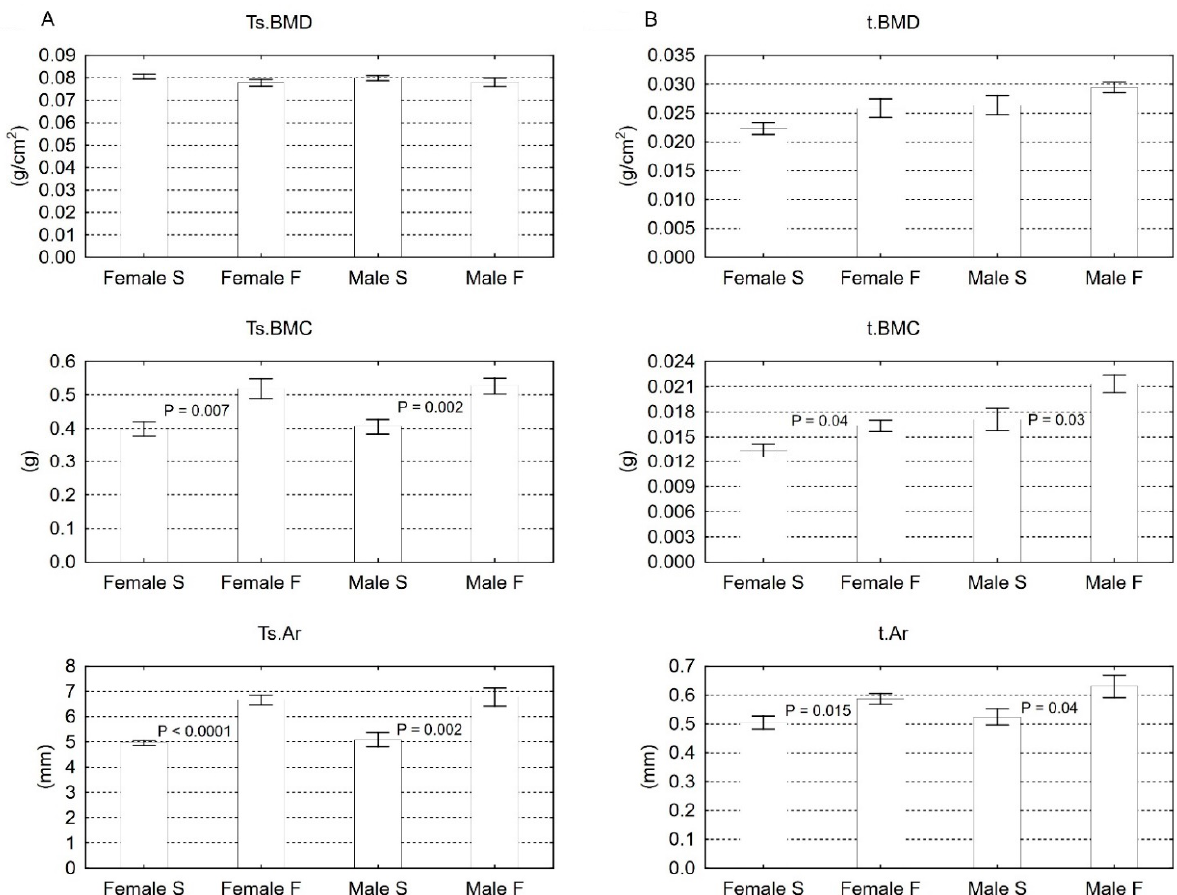
Figure 1. DXA analysis of total skeleton ( A ) and isolated tibia ( B ) of female and male rats on the weaning day. Results are the means ± S.E.M. ( n = 8). Statistically significant differences between S and F groups were established by the t-Student ( p < 0.05). Abbreviations: Ts.BMD–total skeleton bone mineral density; Ts.BMC–total skeleton bone mineral content; Ts.Ar–total skeleton area; t.BMD–tibia bone mineral density; t.BMC–tibia bone mineral content; t.Ar–tibia bone mineral area.